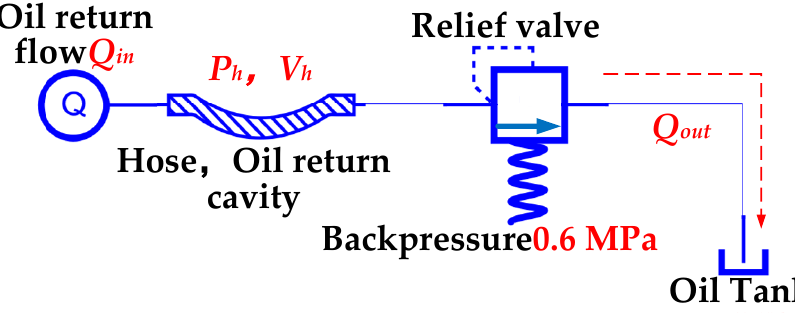
Figure 10. Pressure servo valve power stage.